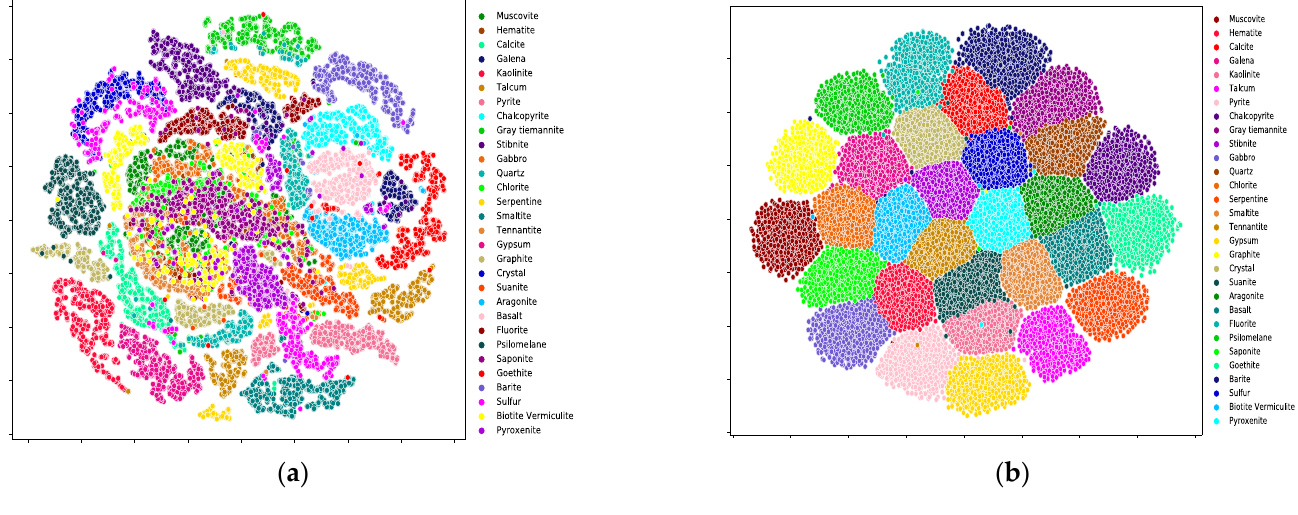
Figure 5. Visualization comparison using the T-SNE technique. ( a ) Original spectral signatures; ( b ) highly discriminative features derived from the developed method.